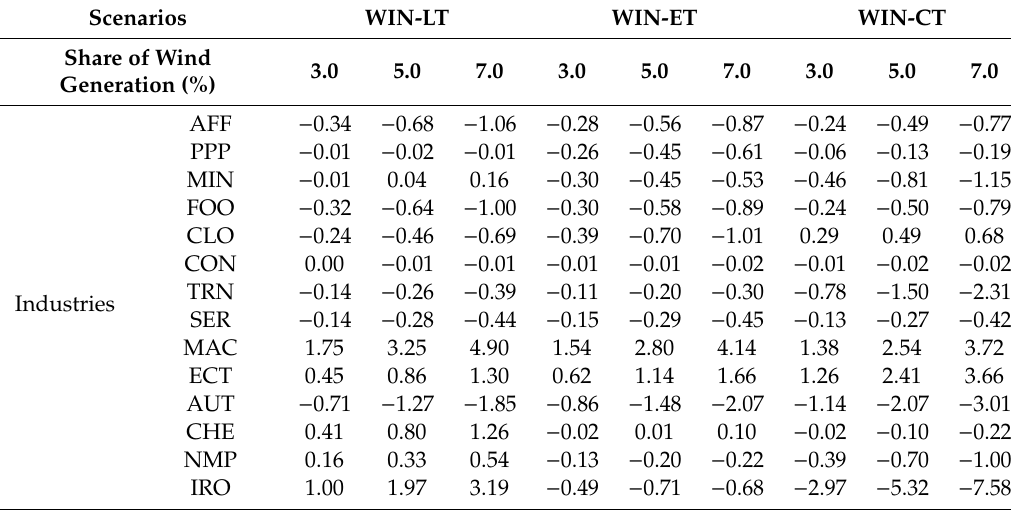
Table 9. Changes in output by industry according to the increase in the share of wind power generation (% changes in output from the base